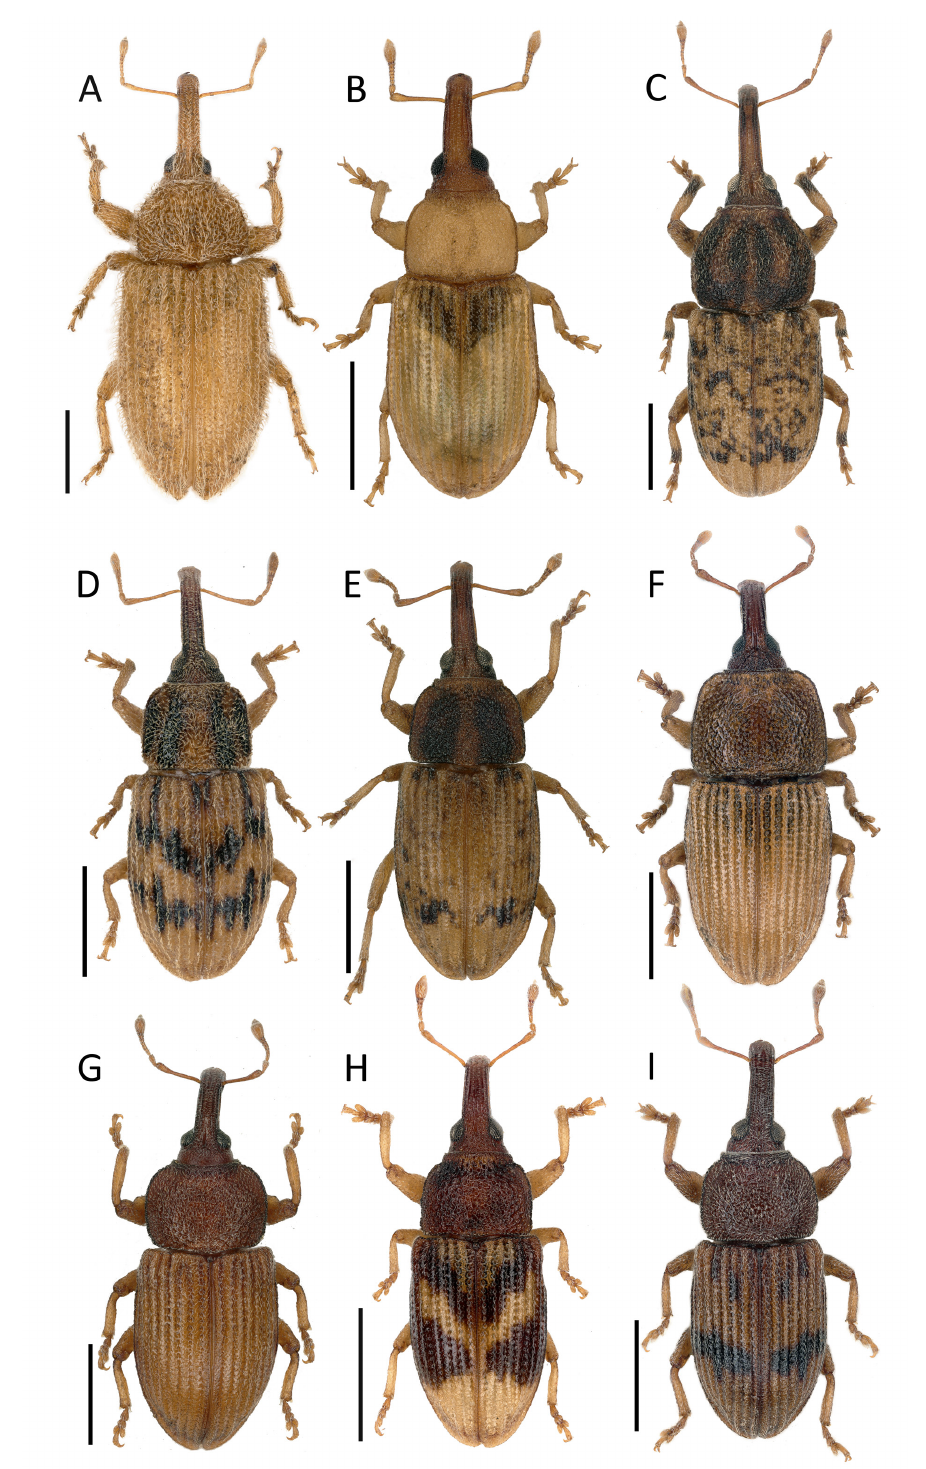
Fig. 2. A–I . Habitus of males of Ebenacobius Haran gen. nov. in dorsal view (part 1). A . E. curvisetis Haran gen. et sp. nov. B . E. rectirostris Haran gen. et sp. nov. C . E . duplicatus Haran gen. et sp. nov. D . E. grobbelaarae Haran gen. et sp. nov. E . E . costalis (Fåhraeus, 1844) gen. et comb. nov. F . E . thoracicus Haran gen. et sp. nov. G . E. xhosa Haran gen. et sp. nov. H . E . san Haran gen. et sp. nov. I . E. kuscheli Haran gen. et sp. nov. Scale bars = 1